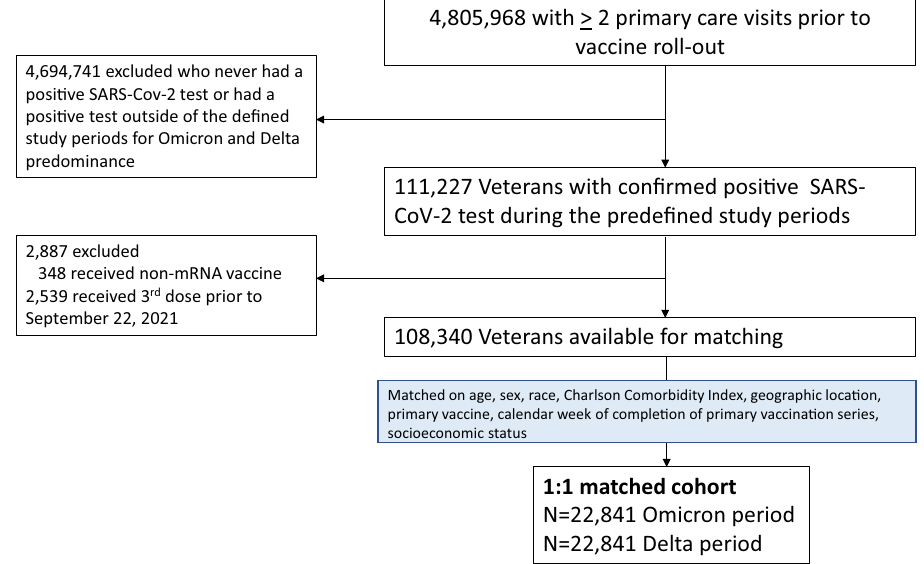
Fig. 1 Overview of study cohort derivation. We constructed a 1:1 matched cohort by matching veterans infected during the Omicron variant period with veterans infected during the Delta variant period using random coarsened exact matching. Individuals were matched on age, sex, race, vaccination status at the time of infection, second vaccine dose administration date, Charlson Comorbidity Index, area deprivation score (as a marker of socioeconomic status), and VA medical center to account for local differences in SARS-CoV-2 transmission, testing, and hospital admission